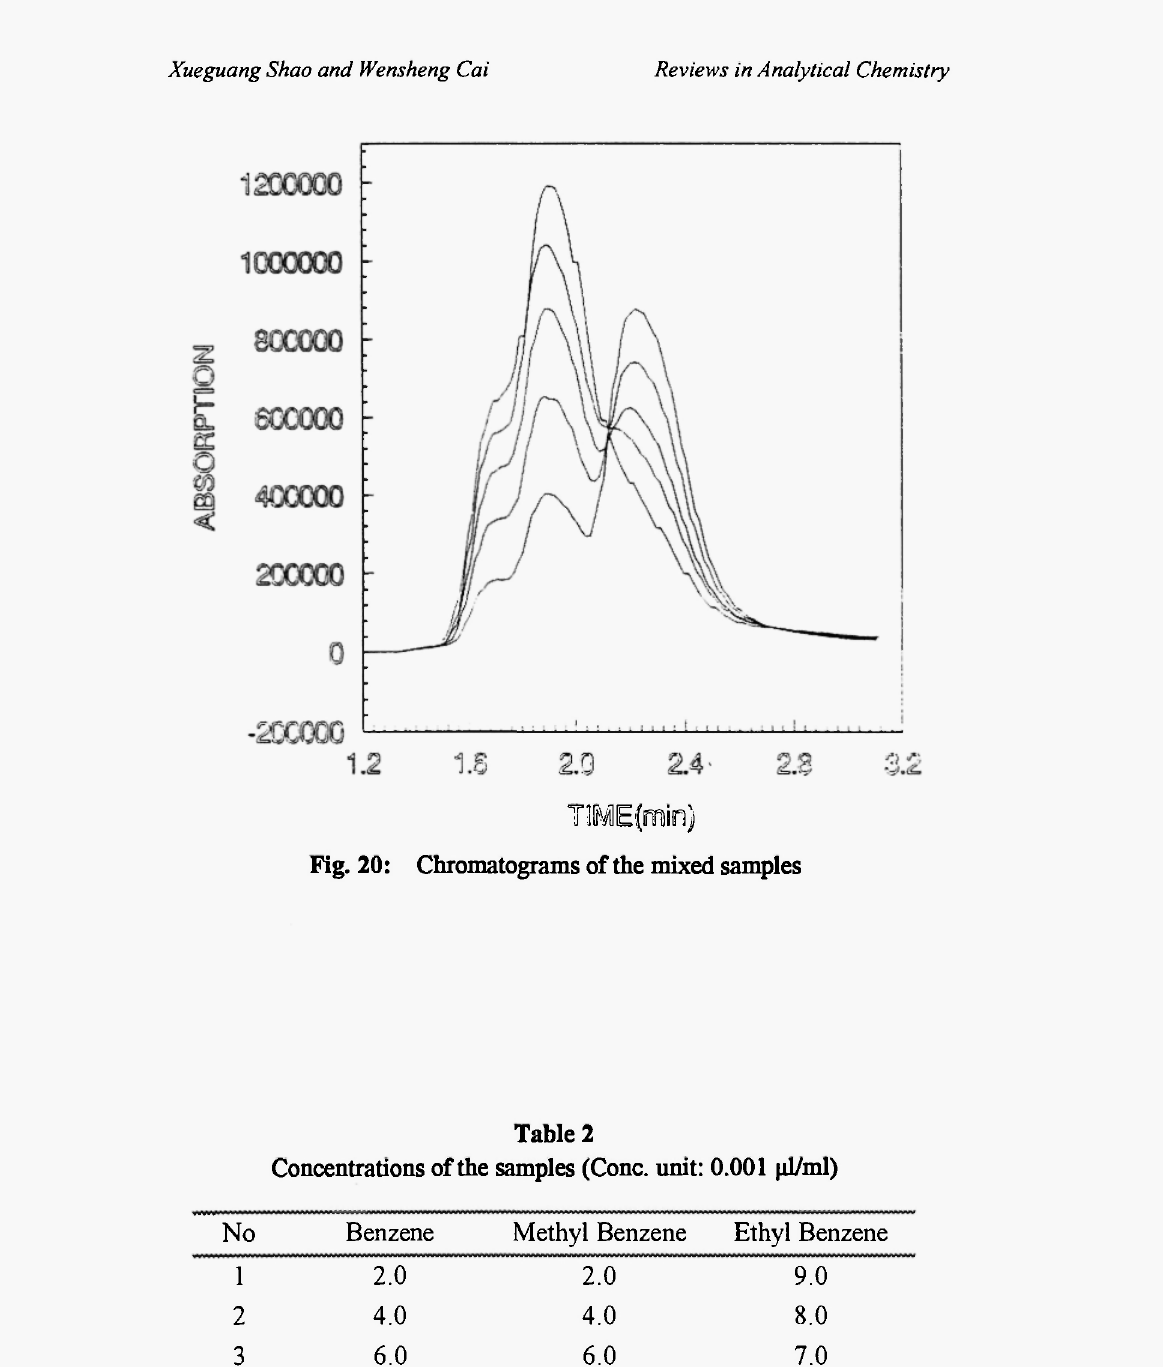
Concentrations of the samples (Cone, unit: 0.001